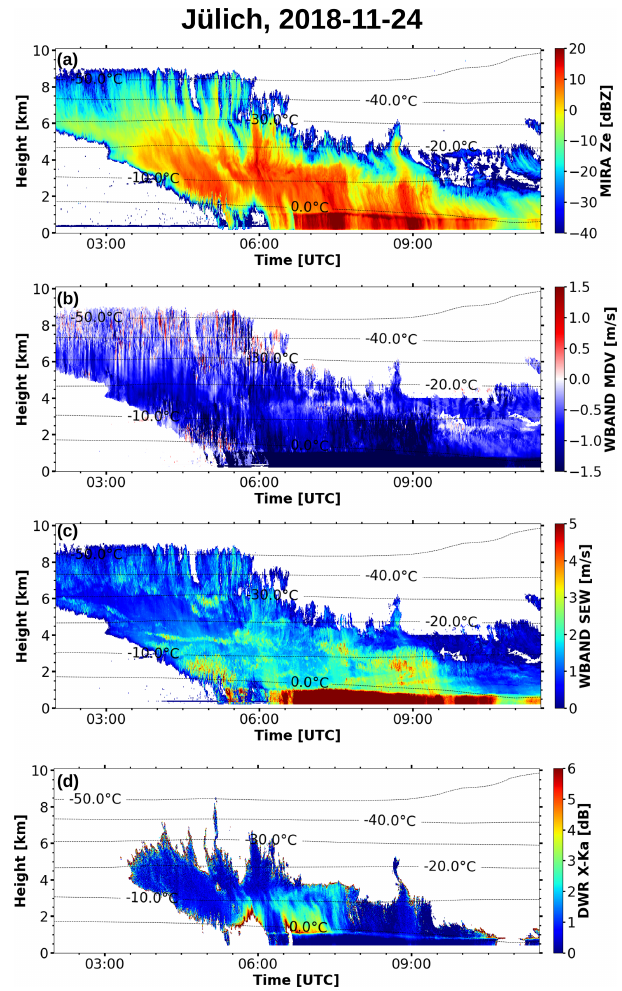
Figure 5. Radar moments measured during the 24 November 2018 case. (a) Equivalent radar reflectivity measured by the Ka-band MIRA radar. (b) Mean Doppler velocity measured by the W-band radar. (c) Spectrum edge width derived from W-band Doppler spectra. (d) Dual-wavelength ratio of X- and Ka-band radar (DWR X , Ka